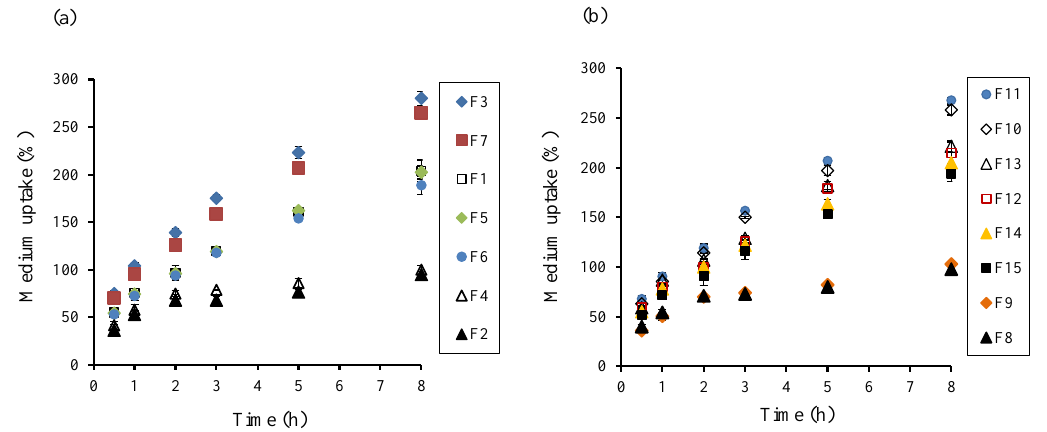
Figure 2. Plots of degree of swelling (medium uptake) vs. time profiles of various formulations based on the Box-Behnken design (BBD) experimental design, ( a ) F1–7 and ( b )